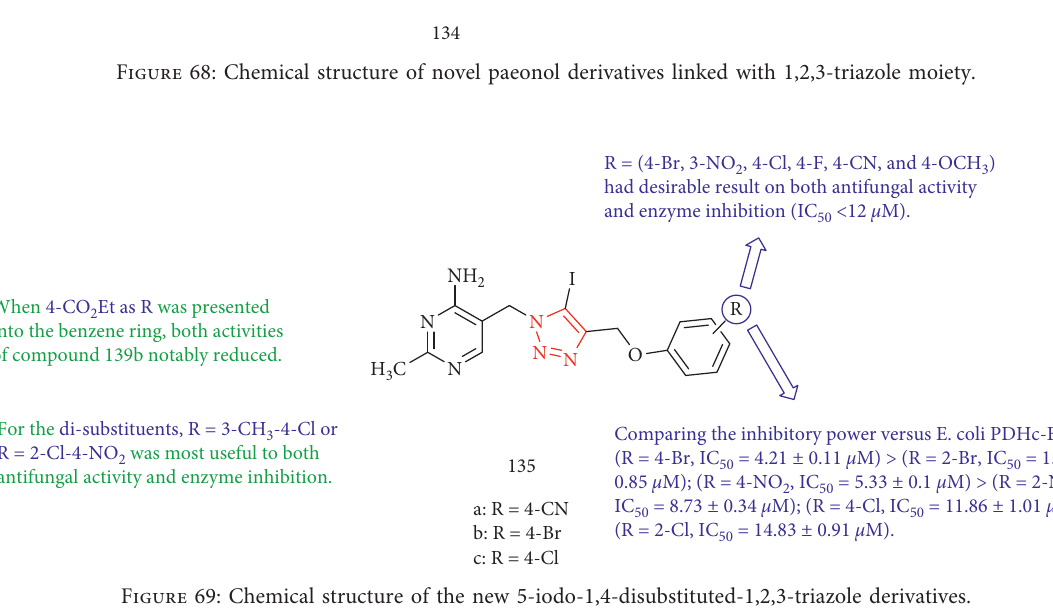
Figure 67: Chemical structure of 4-((1-benzyl/phenyl-1H-1,2,3-triazole-4-yl)methoxy)benzaldehyde analogs. O NNN The compounds having o -fluorophenyl, R O o -trifluoromethylphenyl, o -tolyl and p -methoxyphenyl groups in order, compounds.Paeonol displayed more powerful antifungal activities than other novel O